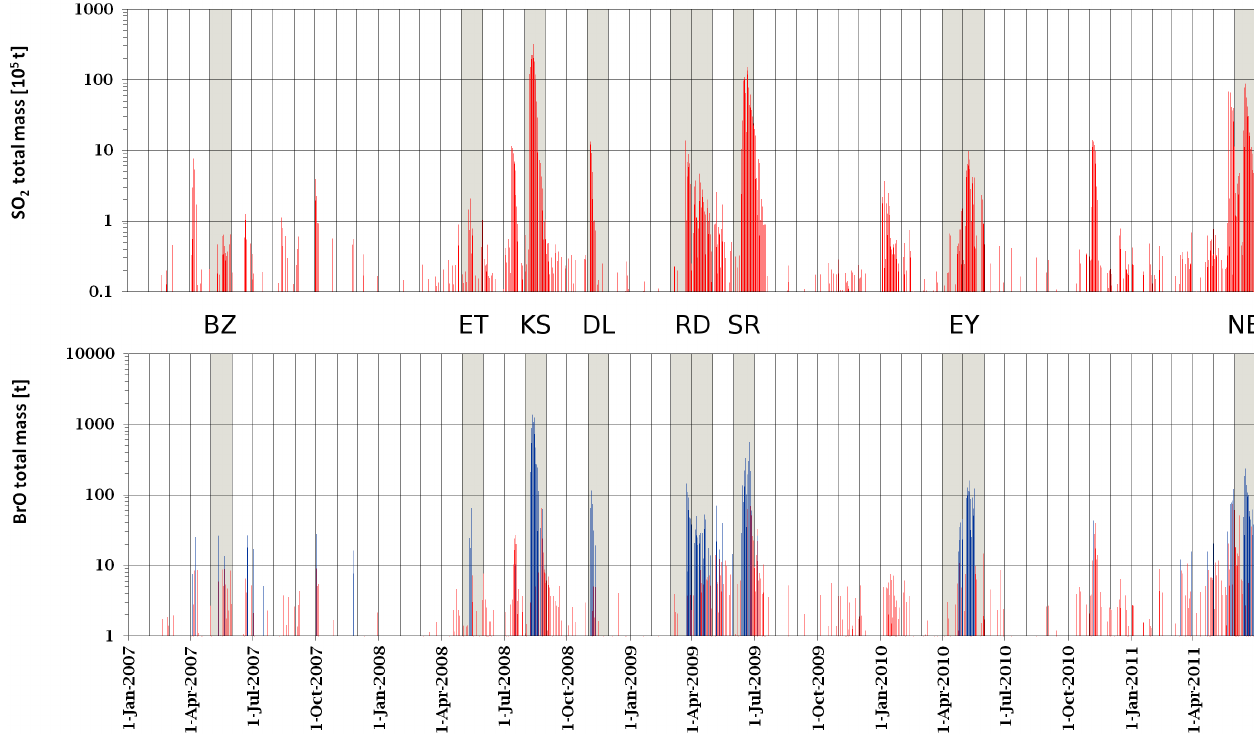
Fig. 6. Time-series of integrated total SO 2 and BrO masses for all investigated volcanic plumes between January 2007–June 2011. Like for the maximum VCDs in Fig. 5, also the integrated BrO masses are significantly enhanced at the same time as the number of SO 2 molecules. For many days, the detected BrO mass is significant ( > two times the corresponding error), as indicated in blue. Please note the logarithmic